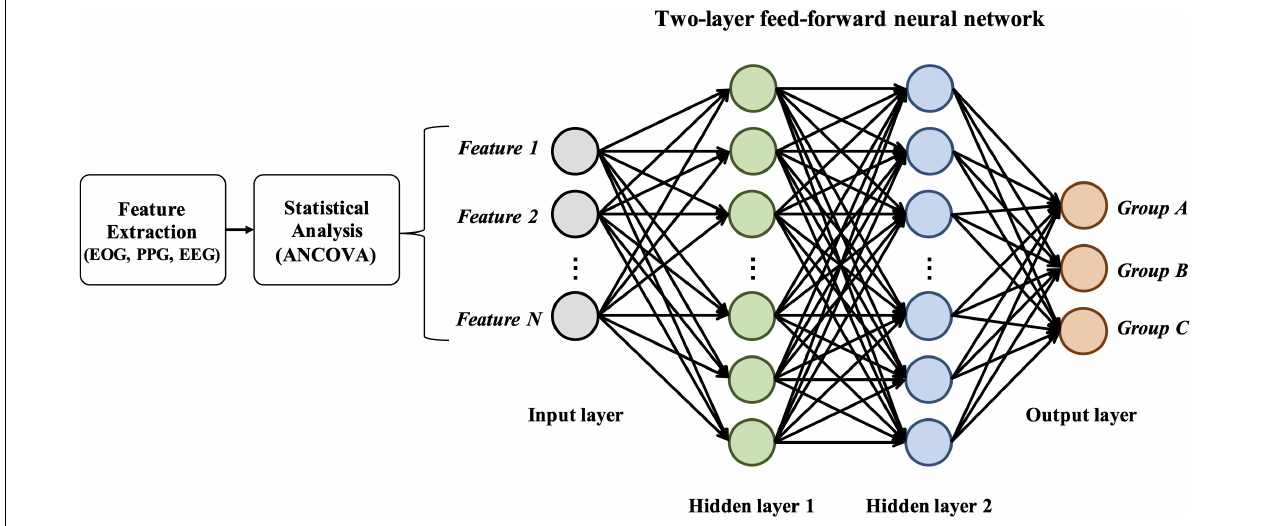
FIGURE 3 | Graphical structure of the two-layer feedforward neural